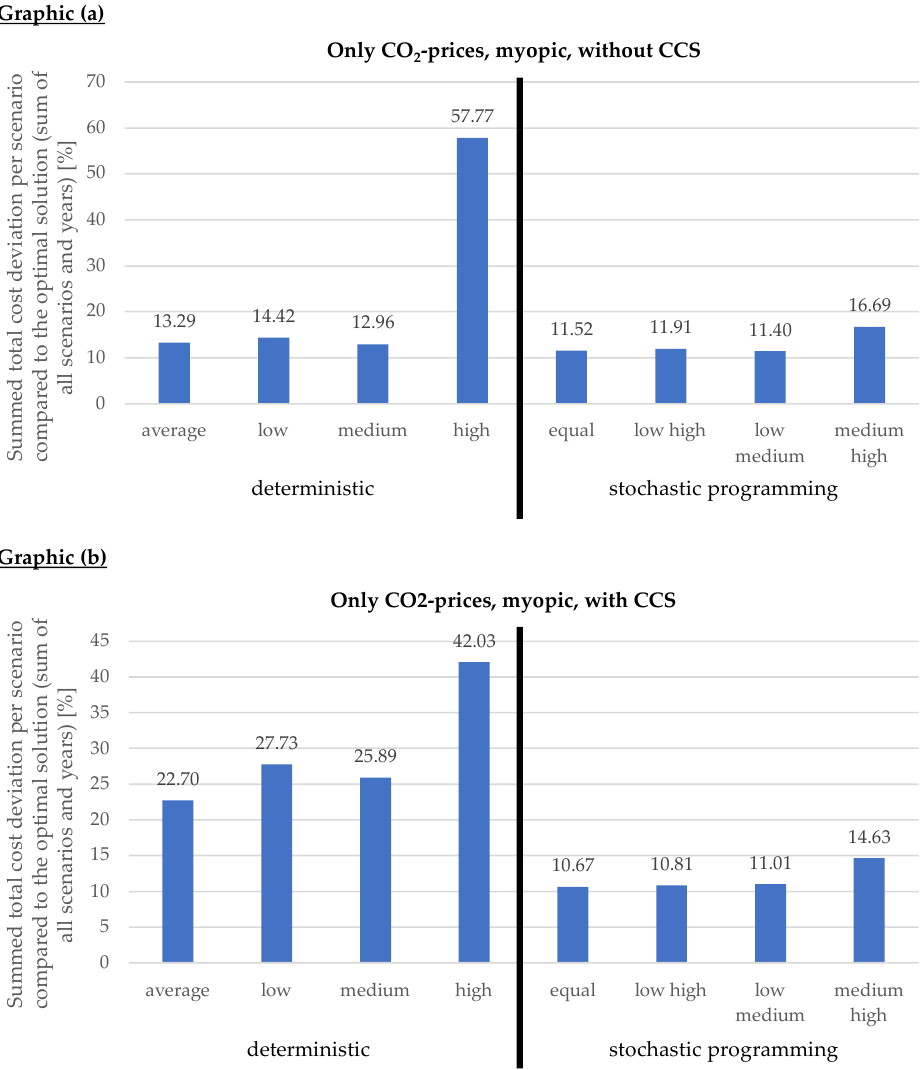
Figure 10. ( a ) STCD per scenario for uncertain CO 2 prices (myopic, without CCS); ( b ) STCD per scenario for uncertain CO 2 prices (myopic, with CCS).